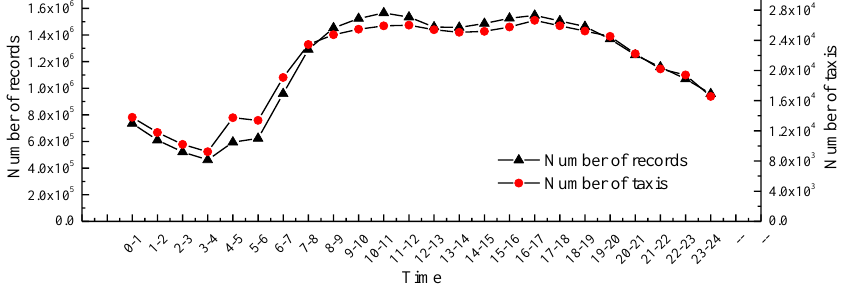
Figure 8. Variation of taxi and record numbers during one day.